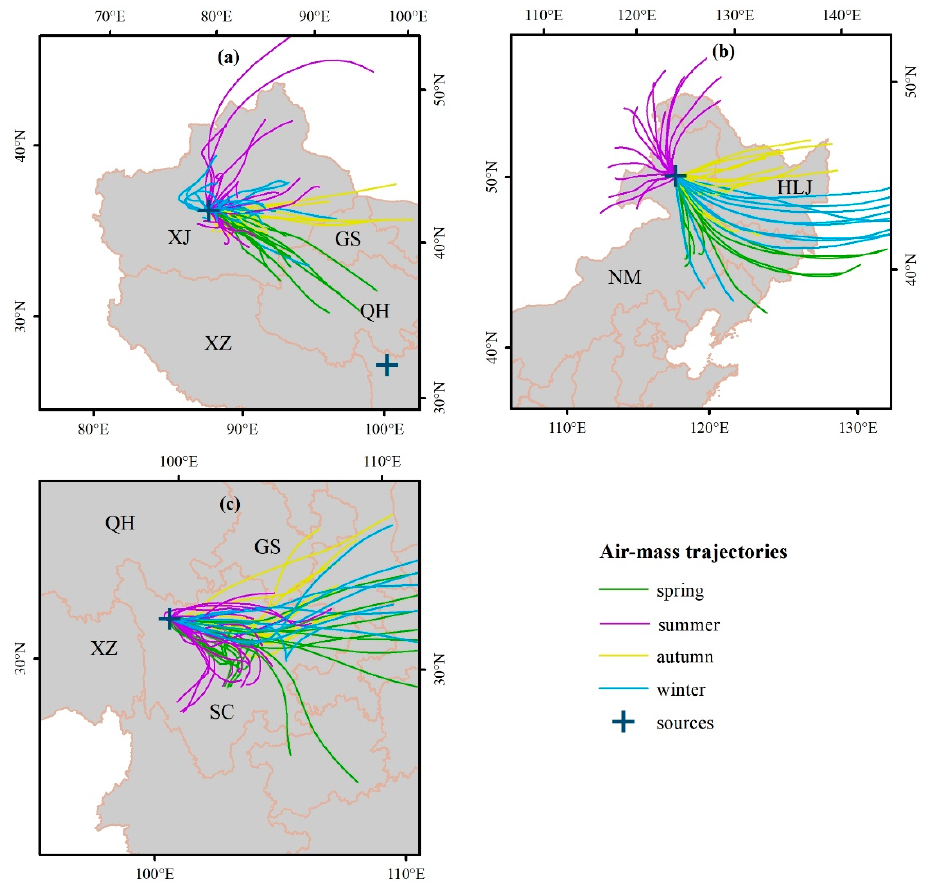
Figure 4. Locations of three typical high CH 4 concentration areas and air-mass back-trajectories at an altitude of 3 km: ( a ) Region Ⅰ ; ( b ) Region Ⅱ ; ( c ) Region Ⅲ .